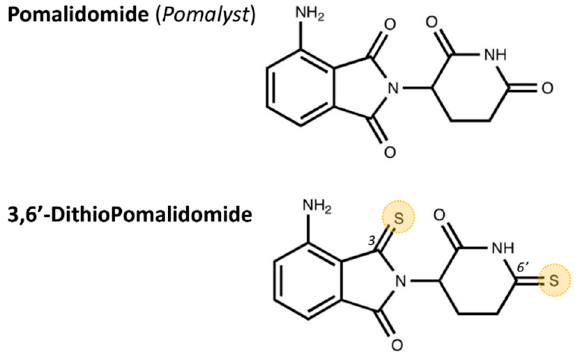
Figure 1. Chemical structures of Pomalidomide (Pom; clinically known as Pomalyst ) and the new analog 3,6 ′ -DithioPomalidomide (DP), with sulfurs shown in the marked 3 and 6 ′ positions (yellow highlights).